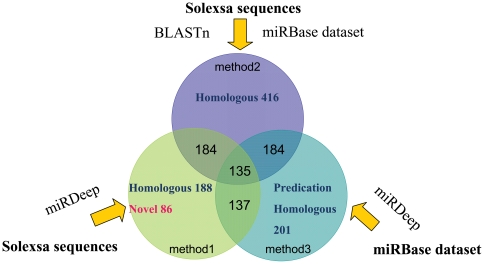
Comparison of miRNA sequences identification with different Methods.